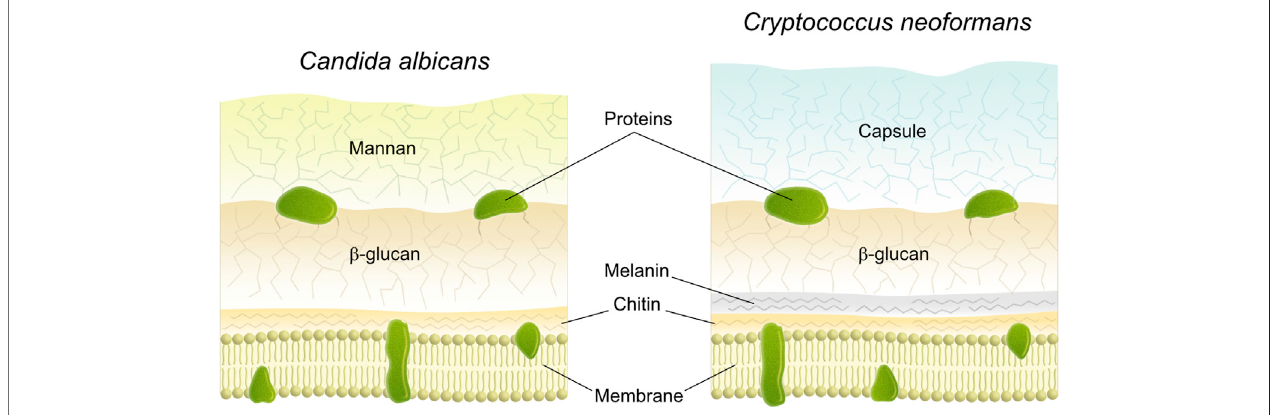
FIGURE 1 | Schematic drawing of the cross section of the cell wall of fungi a) Candida albicans and b) Cryptococcus neoformans (Gow et al., 2017).